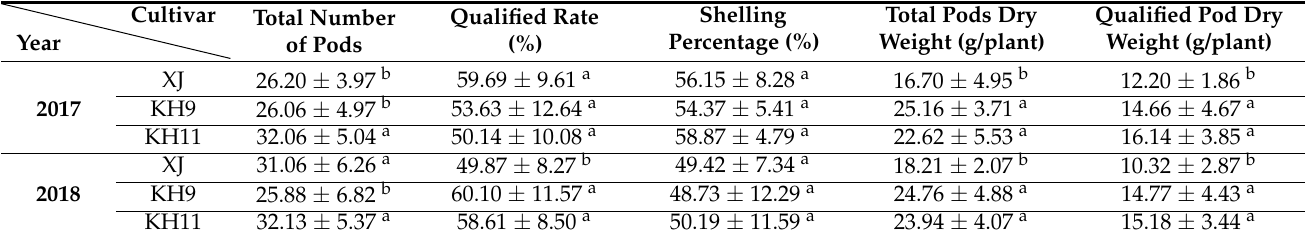
(Table 1). The results revealed that KH11 had the highest total number of pods. The qualified rate was defined as the number of qualified pods divided by the total number of pods. No difference in the qualified rate of these three cultivars was noted in 2017, but the qualified rate of XJ was significantly lower than that of the other two cultivars in 2018. The shelling percentage was defined as the seed weight per plant divided by the pod weight per plant; no significant difference was observed in the shelling percentage among the three cultivars. The dry weights of all pods and of qualified pods were higher in KH9 and KH11 than in XJ. These results indicated that the yields of edamame varied among these cultivars. Table 1. Yield component data of XJ, KH9, and KH11 in the